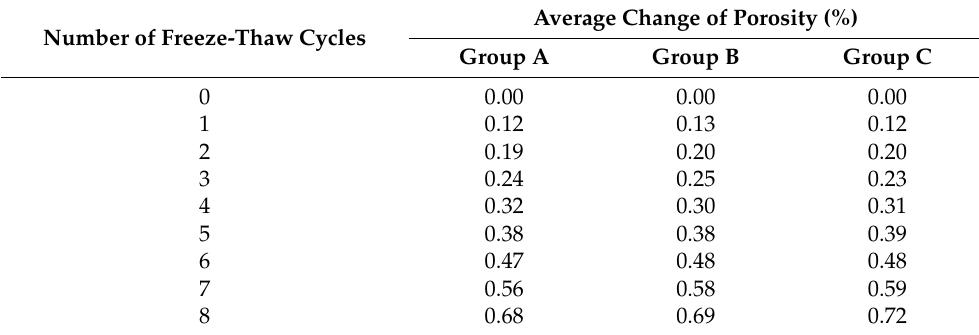
Table 1. Average change in porosity after freeze-thaw cycles for three groups of unloaded-damaged samples.